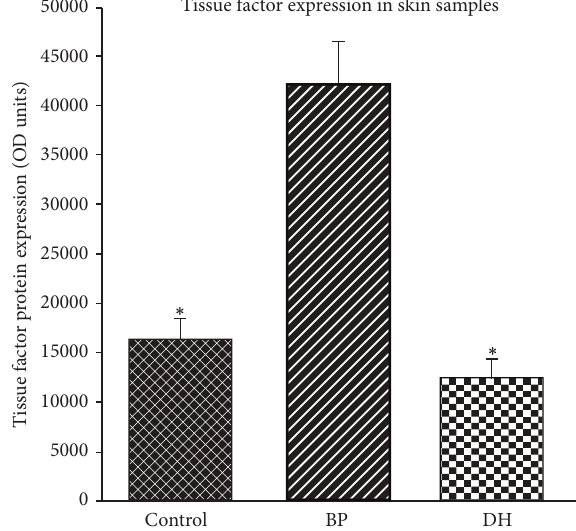
Figure 4: Tissue factor protein immunoblotting.